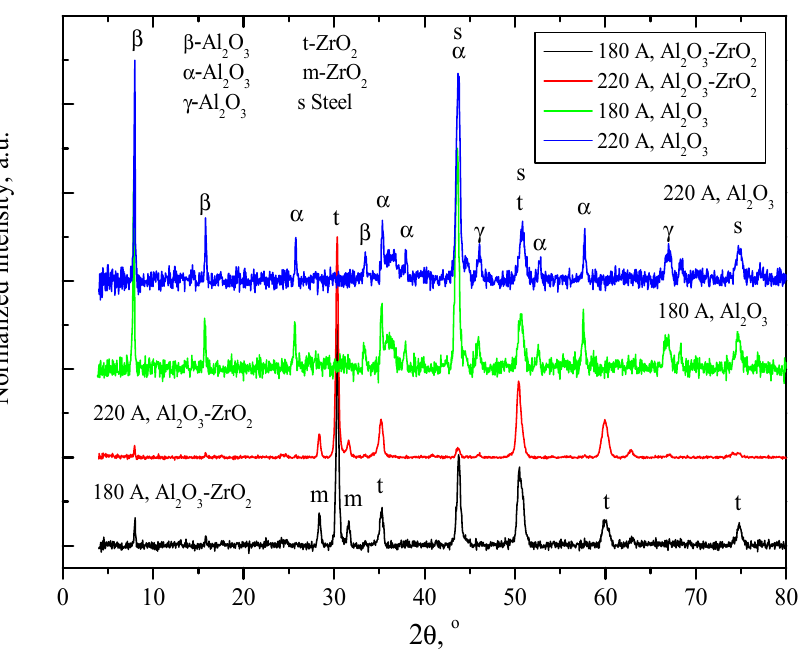
Figure 4. XRD patterns of the of Al 2 O 3 and Al 2 O 3 -ZrO 2 coatings.